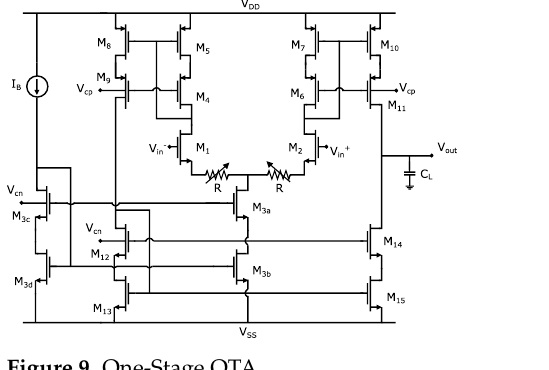
Figure 8. OTA adders.